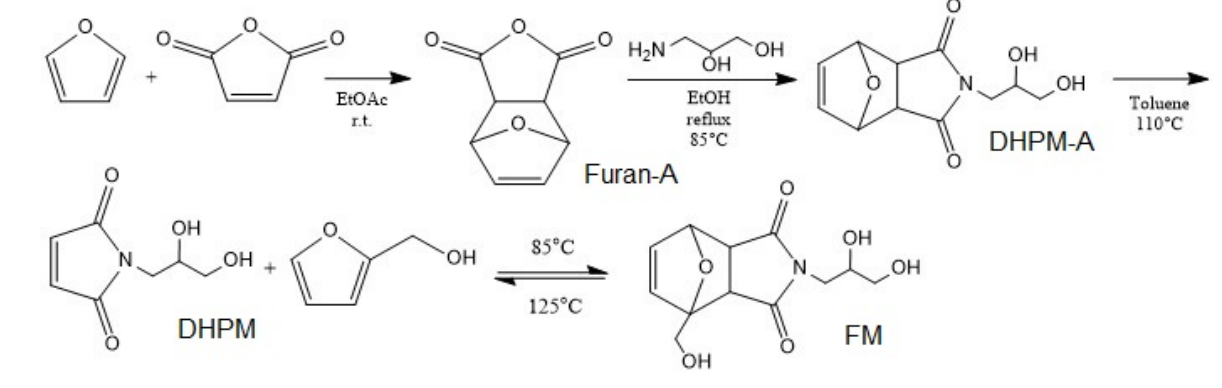
Figure 1. Synthesis of DA healing agent.